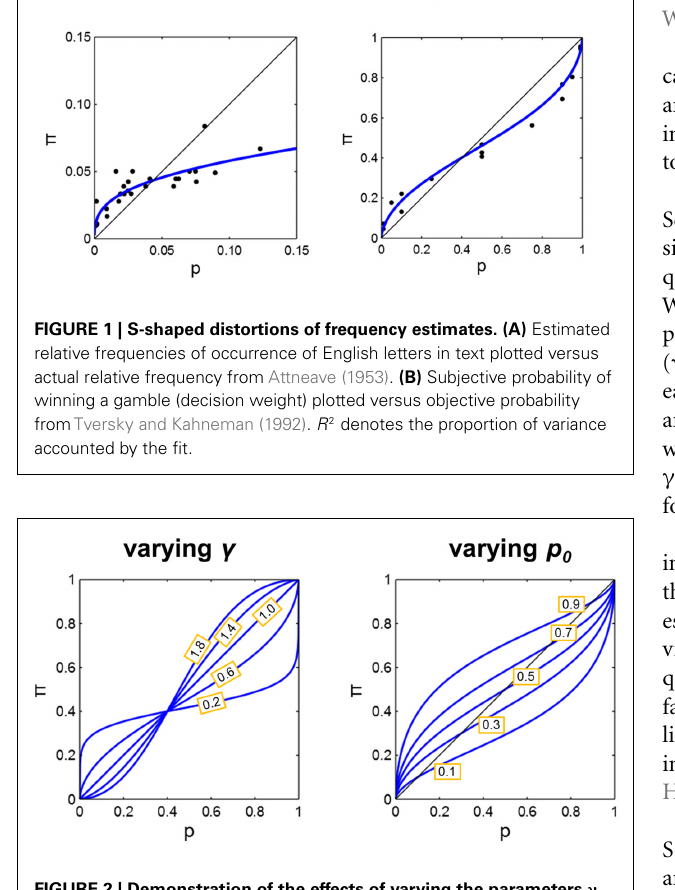
FIGURE 2 | Demonstration of the effects of varying the parameters γ and p 0 . The parameter p 0 in the LLO function is the “fixed point” of the transformation, the value of p which is mapped to itself.The parameter γ , is the slope of the linear transformation on log odds scales, and on linear scales, is the slope of the curve at the crossover point p 0 . Left: p 0 fixed at 0.4 and γ varied between 0.2 and 1.8. Note that the line at γ = 1 overlaps with the diagonal line, i.e., no distortion of probability. Right: γ fixed at 0.6 and p 0 varied between 0.1 and